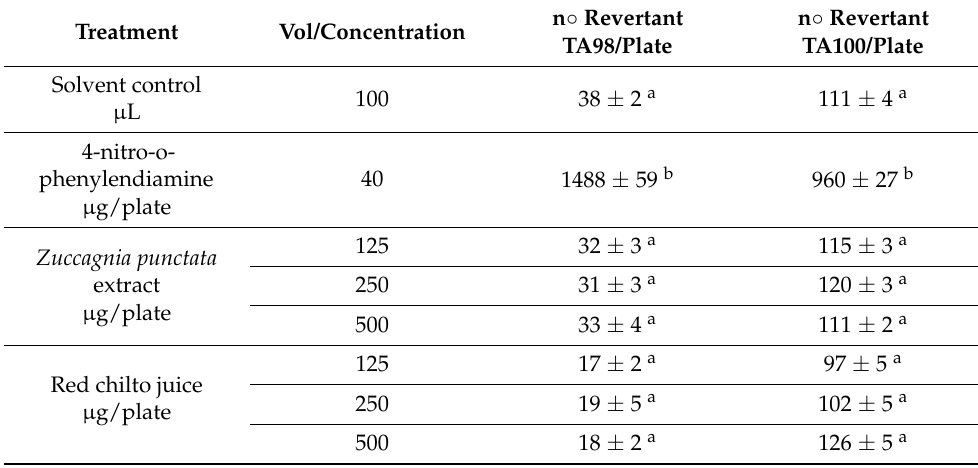
Table 5. Number of revertant colonies in the mutagenic Ames test.